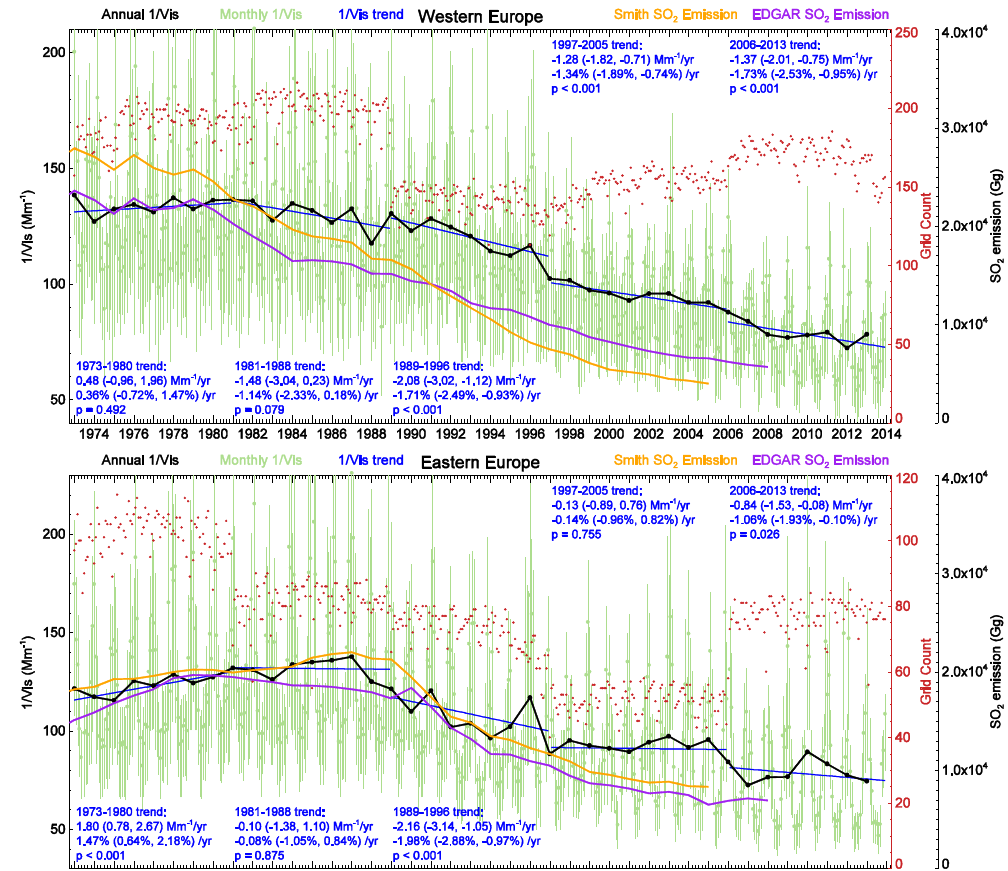
Figure 10. Regional time series analysis of 1/Vis and SO 2 emission over western and eastern Europe. The long ticks on the horizontal axis indicate January of the year, where all annual values are plotted. Light green dots represent the average monthly 1/Vis of all qualified stations (error bars showing the 25th and 75th percentile) in the defined region. Red dots show the number of grid cells for averaging, and data gaps indicate months with less than 75% of the total grids for each period. Blue lines and text represent the 1/Vis trends calculated using the monthly anomalies for each period. Trends in parentheses are the 95% confidence intervals. Black lines are the annual 1/Vis averaged from at least 8 monthly values. The Smith SO 2 emissions in orange are the total emission of all countries listed in Table 2 for each region. The EDGAR SO 2 emissions in purple are summed from all pixels inside the defined region (Fig.